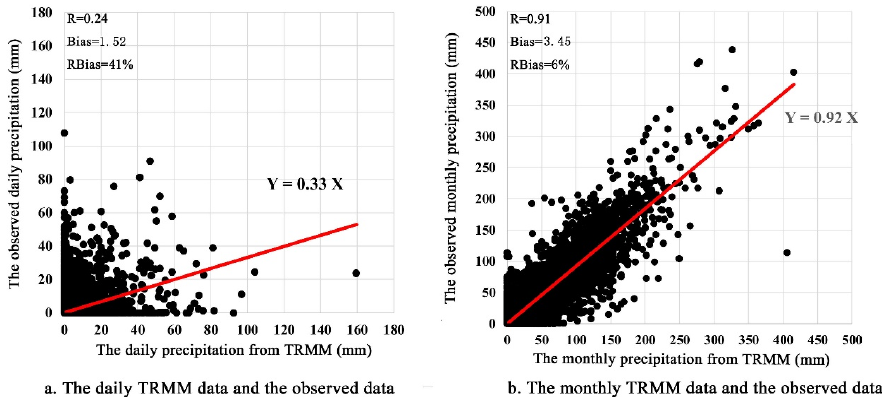
Figure 2. Comparison between daily and monthly TRMM data and observed values.